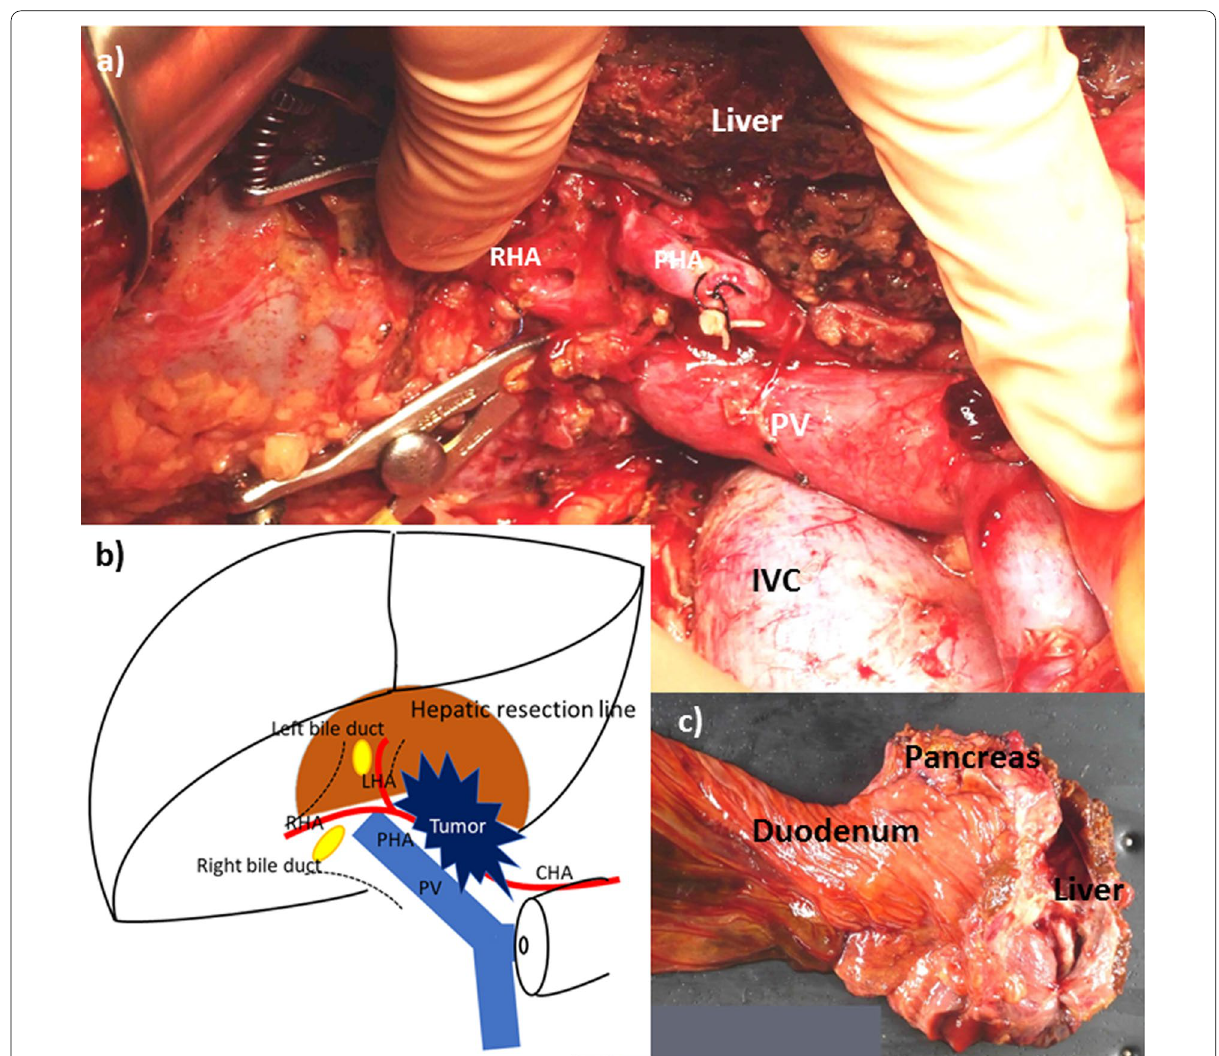
Fig. 2 Intraoperative photograph and resected specimen of the pancreatic head and liver. a The left and right bile ducts that have been dissected are clamped with bulldog forceps. Lymphatic and connective tissue in the hepatoduodenal ligament remains between the PHA and the RHA. RHA right hepatic artery, PHA proper hepatic artery, PV portal vein, IVC inferior vena cava. b LHA left hepatic artery, RHA: right hepatic artery, PHA proper hepatic artery, CHA common hepatic artery, PV portal vein. c The mucus has been removed between the pancreas and the